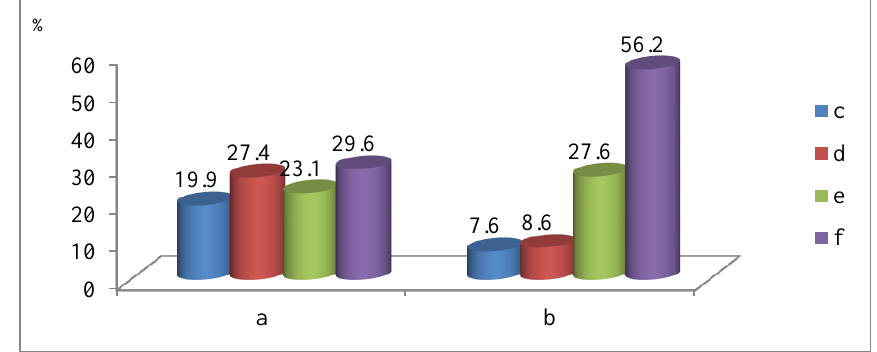
Fig. 6. Schoolchildren’s walks in the fresh air: a – weekdays; b – days off; c – less than 1 hour/day; d - 1-2 hours/day; e - 2 and more hours/day; f – more than 3 hours a